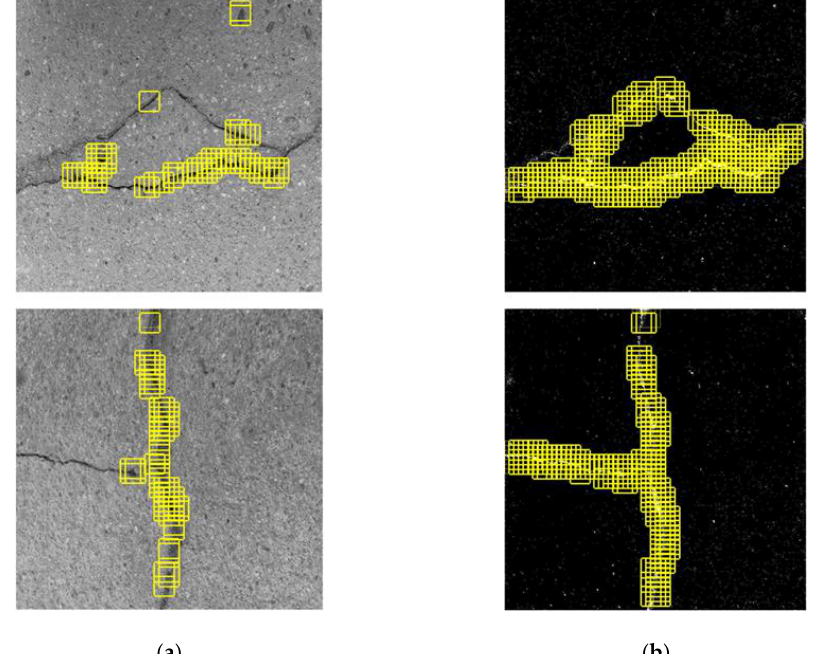
Figure 24. Results of crack position detection (CPD) based on ( a ) the original CPD and ( b ) the MLP–CNN, with low color contract between crack and background.